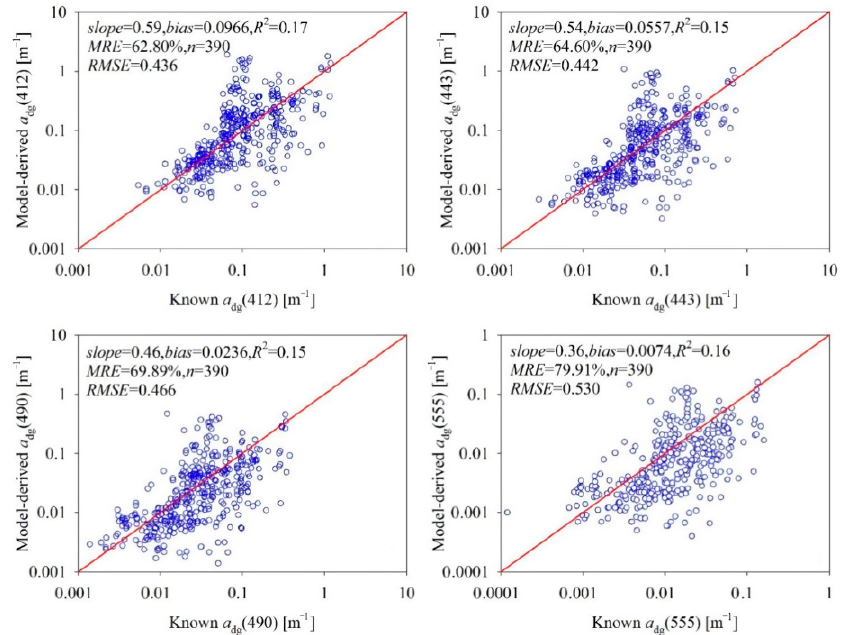
Figure 10. Accuracy of the remote-sensed coefficient of absorption of non-phytoplankton using GIOP model.